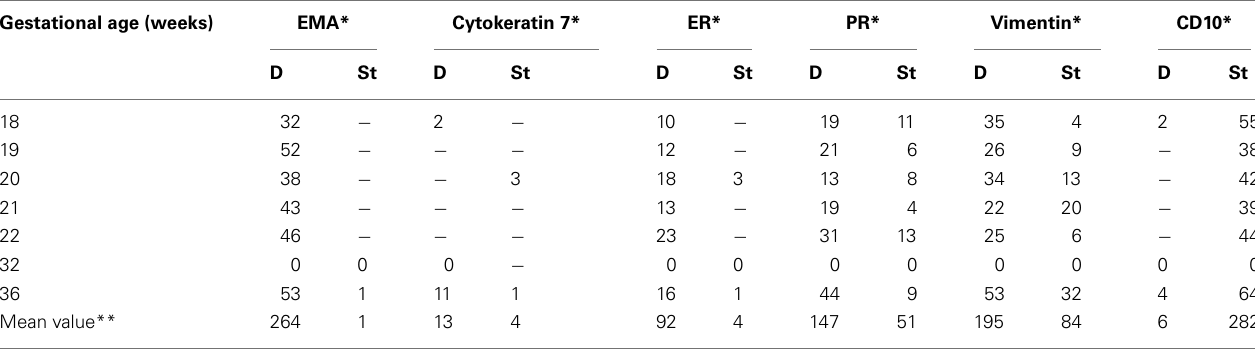
D, embryonic duct; St, Stromal layer; *, percentage of cells expressing the indicated marker; mean value** [represents a ratio of the number of counted cells (200) divided by the number of immunolabeled